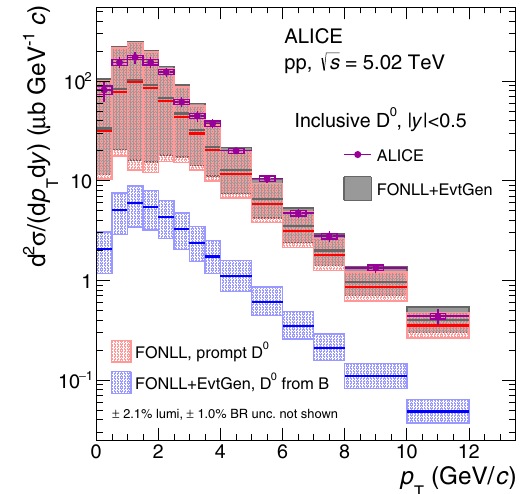
Fig. 12 Inclusive D 0 mesons (including also D 0 mesons from beauty- √ s = 5 . 02 TeV, from hadron decays) in | y | < 0 . 5 in pp collisions at the analysis without decay-vertex reconstruction, compared to FONLL pQCD calculations [7,8] with the B → D + X decay kinematics from the EvtGen package [37] (grey boxes). The contributions of prompt D 0 fromFONLL(red)andD 0 fromB-mesondecaysfromFONLL+EvtGen (blue) are also shown separately. The vertical error bars and the empty boxes represent the statistical and systematic uncertainties, respectively